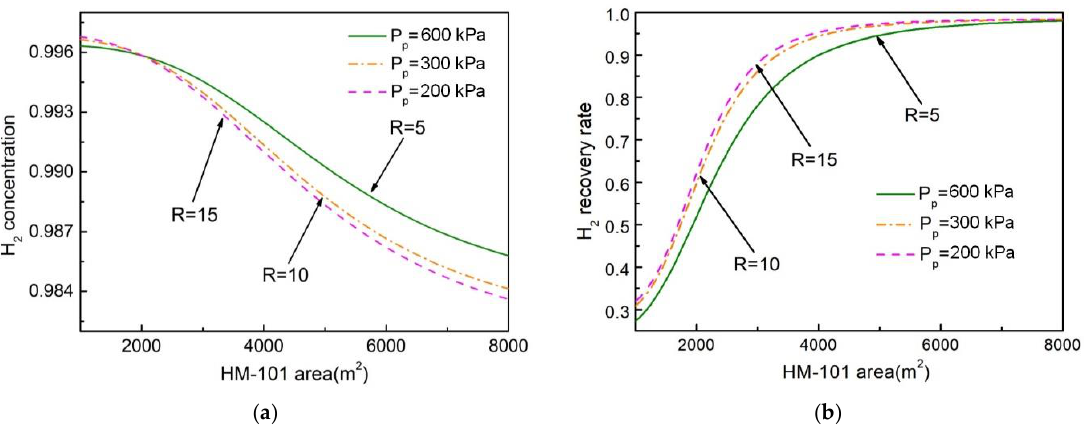
Figure 7. Effect of HM-101 area on H 2 concentration and recovery rate under different pressure ratios. ( a ) Effect of HM-101 area on H 2 molar concentration; ( b ) effect of HM-101 area on H 2 recovery